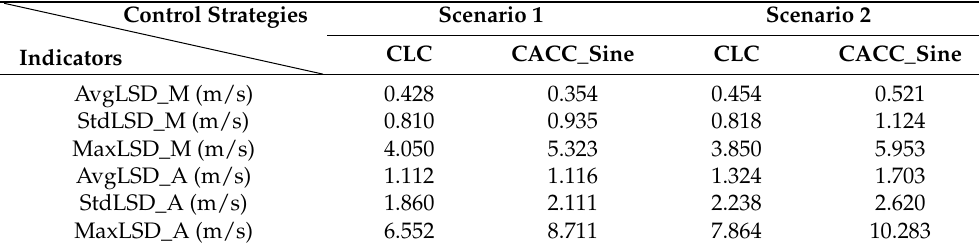
Table 3. Indicator comparison for longitudinal speed of two control